Question: How would you classify this visualization?
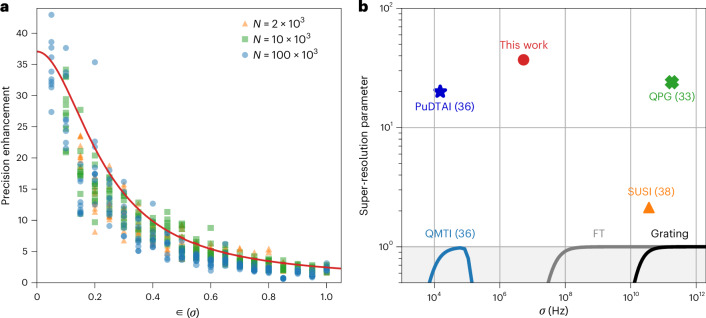
Answer: line